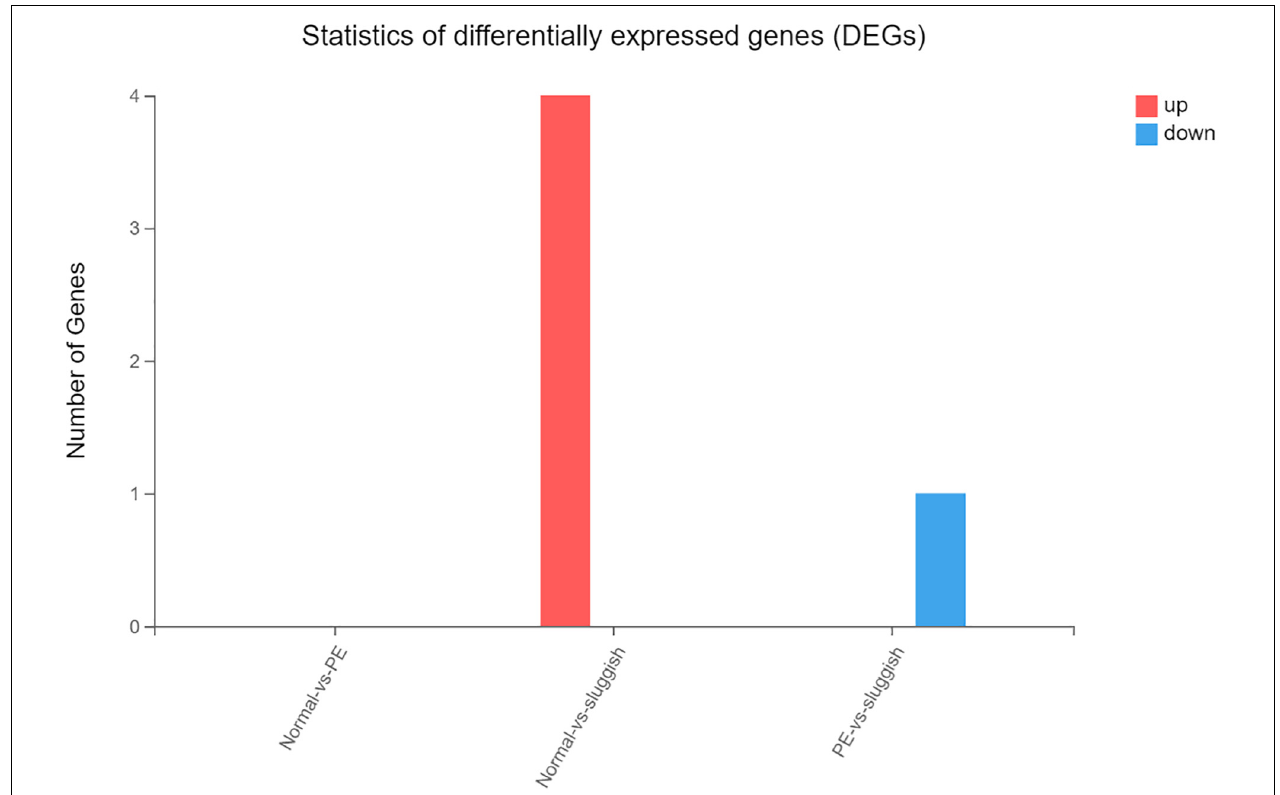
FIGURE 4 | The number of up-regulated and down-regulated genes in the comparison of different grades.